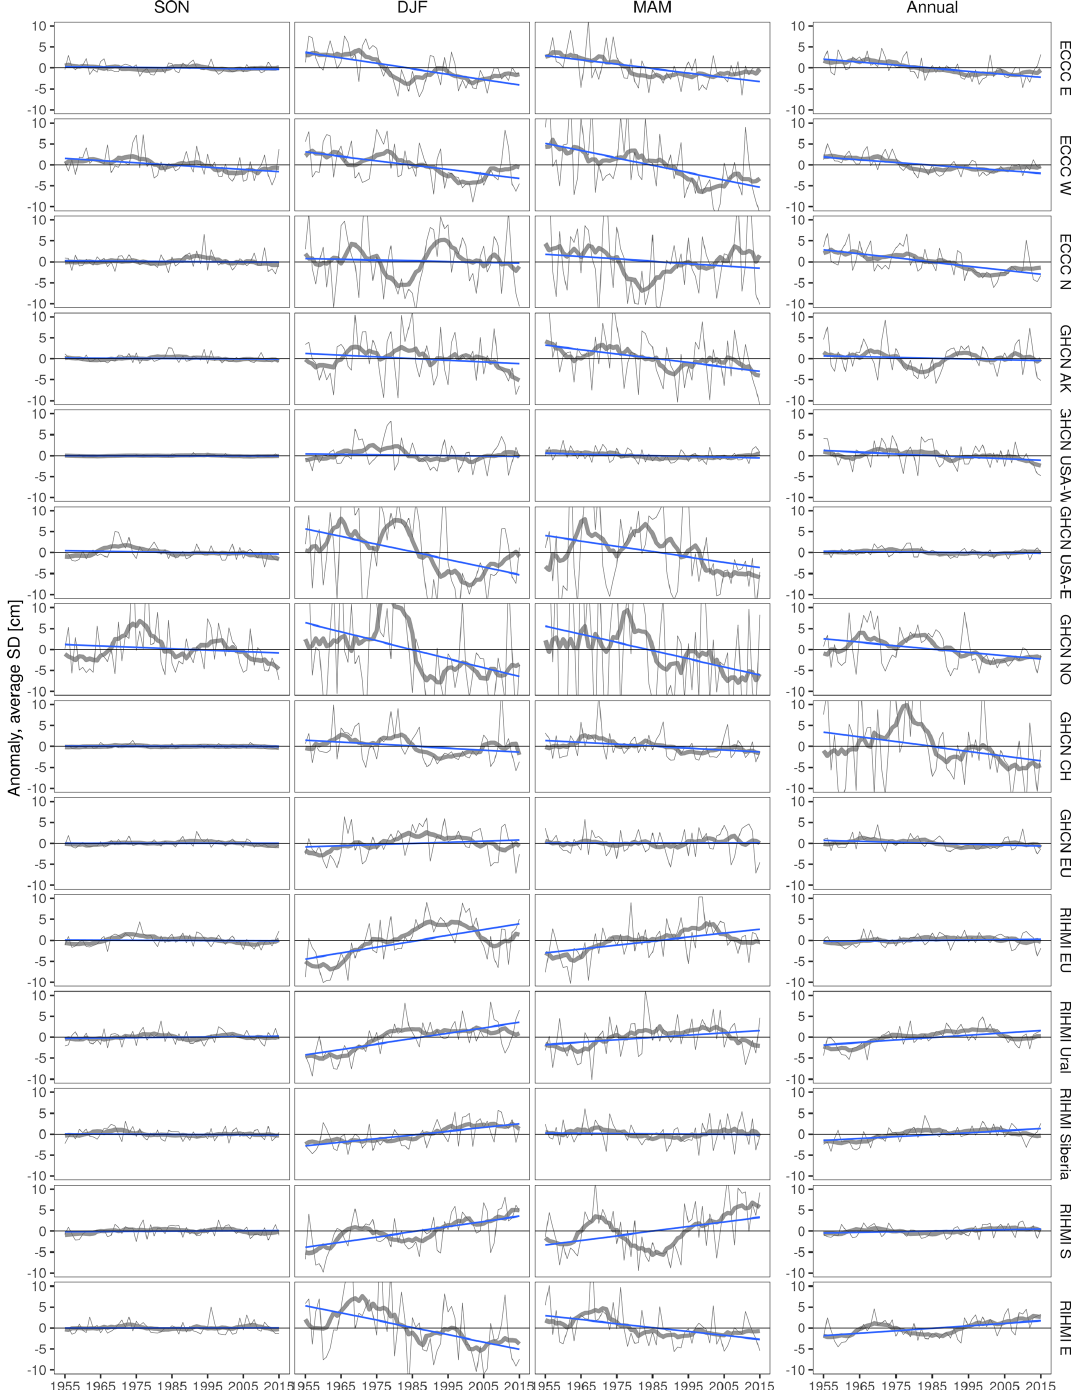
Figure A9. Annual and seasonal anomalies in snow depth (SD) per spatial region compared to the 1955–2015 reference period. Thick gray lines show the 10-year running